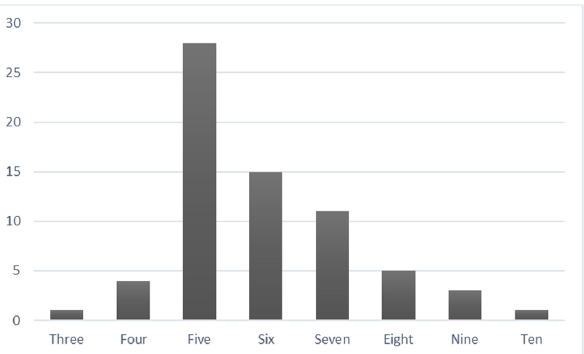
Figure 1. Frequency of young people ( n = 1–28) associated with each number of total reported support needs ( k = 3–10).